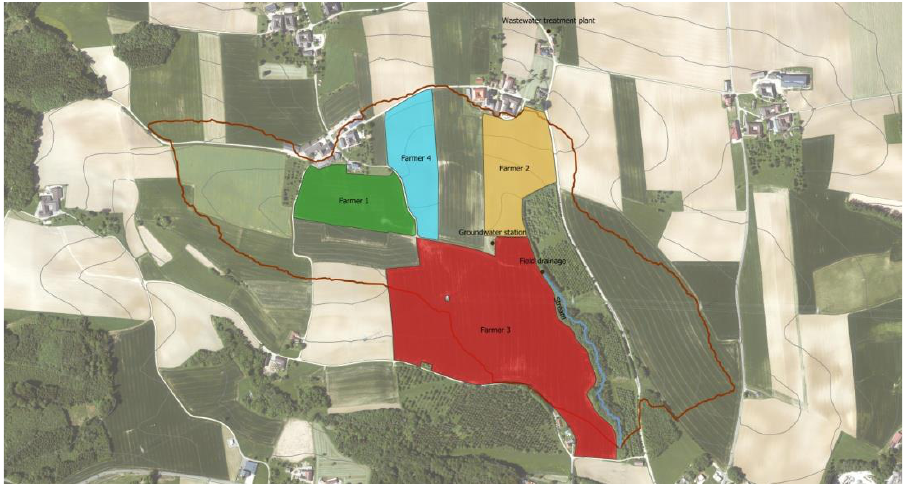
Figure 4. Aerial view of the HOAL in Petzenkirchen, Lower Austria. The limit of the HOAL is depicted by the red line. The sampled fields are colored by farmer. Green, yellow and red fields are sown with corn. The field in blue is sown with wheat. The blue line represents a stream (i.e., compartment “river”). Alongside there is a field drainage and groundwater station. The wastewater treatment plant is outside the catchment area, next to the house of farmer